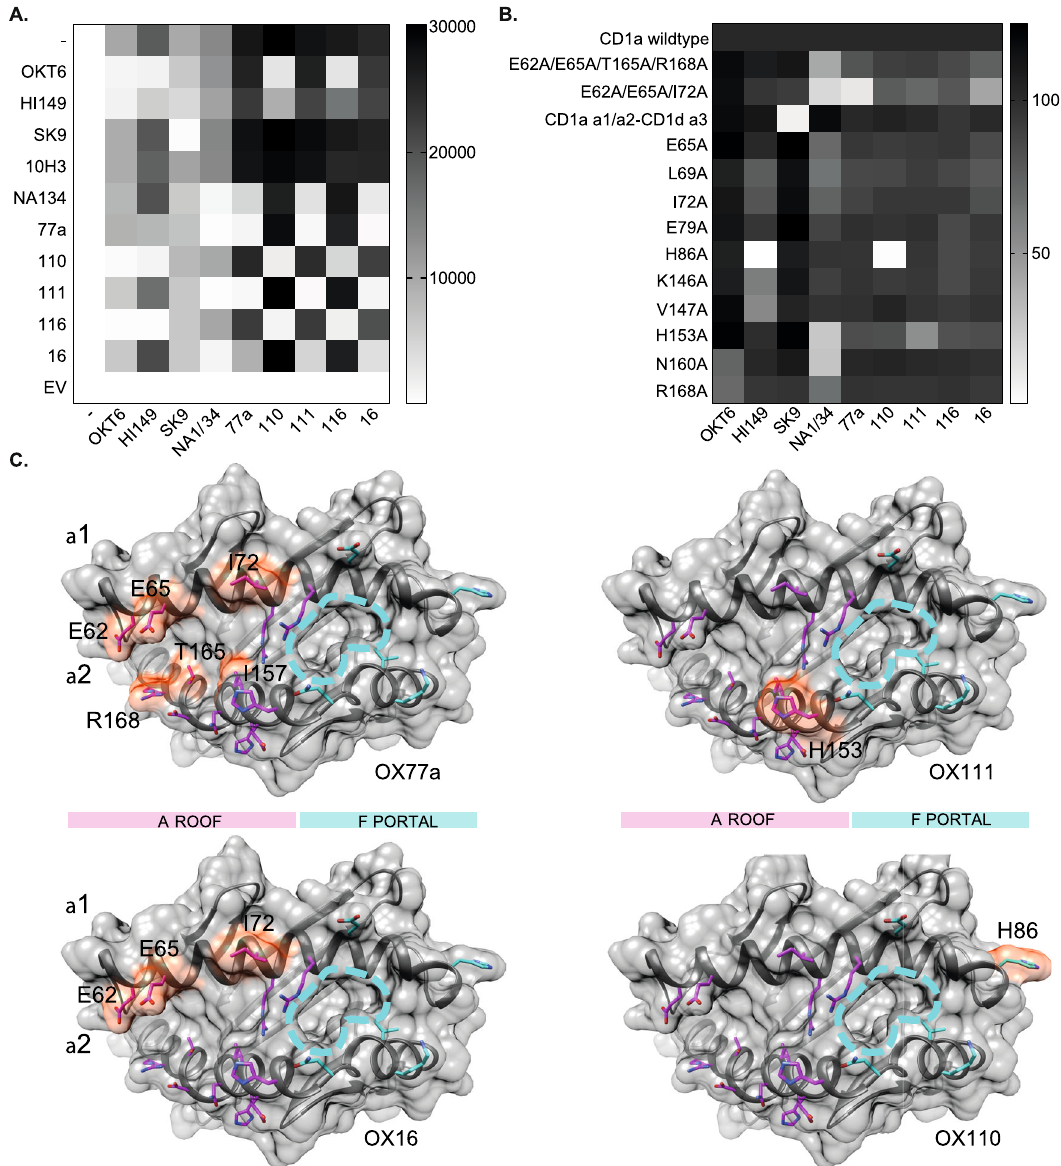
Fig. 3 |CD1a epitopeanalysis.A MatrixheatmaprepresentationofCD1aantibody binding by fl ow cytometry as measured by CD1a-AF647 mean fl uorescence inten- sity (MFI). Before staining of CD1a-K652 with anti-CD1a antibodies conjugated to fl uorophoreAF647 (horizontalaxis),the relevant puri fi edantibodies (vertical axis) were incubated with the cells to assess interference in CD1a binding of the AF647- conjugatedantibodies.Greyscaleshowsdegreeofbinding,withthetoneinthetop row ( − ) indicating no interference. Representative of 3 independent